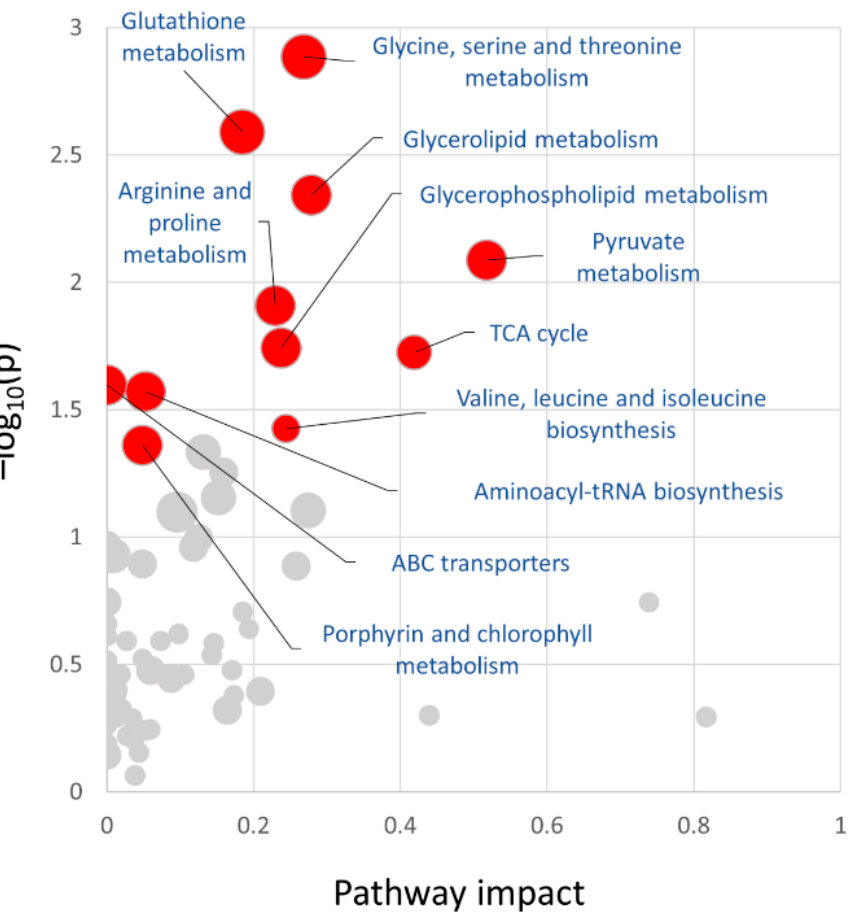
Figure 7. Metabolic pathway impacted by identified differentially abundant compounds. Proteins, lipids, and metabolites listed in Figures 4–6 were analyzed using MetaboAnalyst. Highlighted pathways represent significantly enriched processes ( p < 0.05).